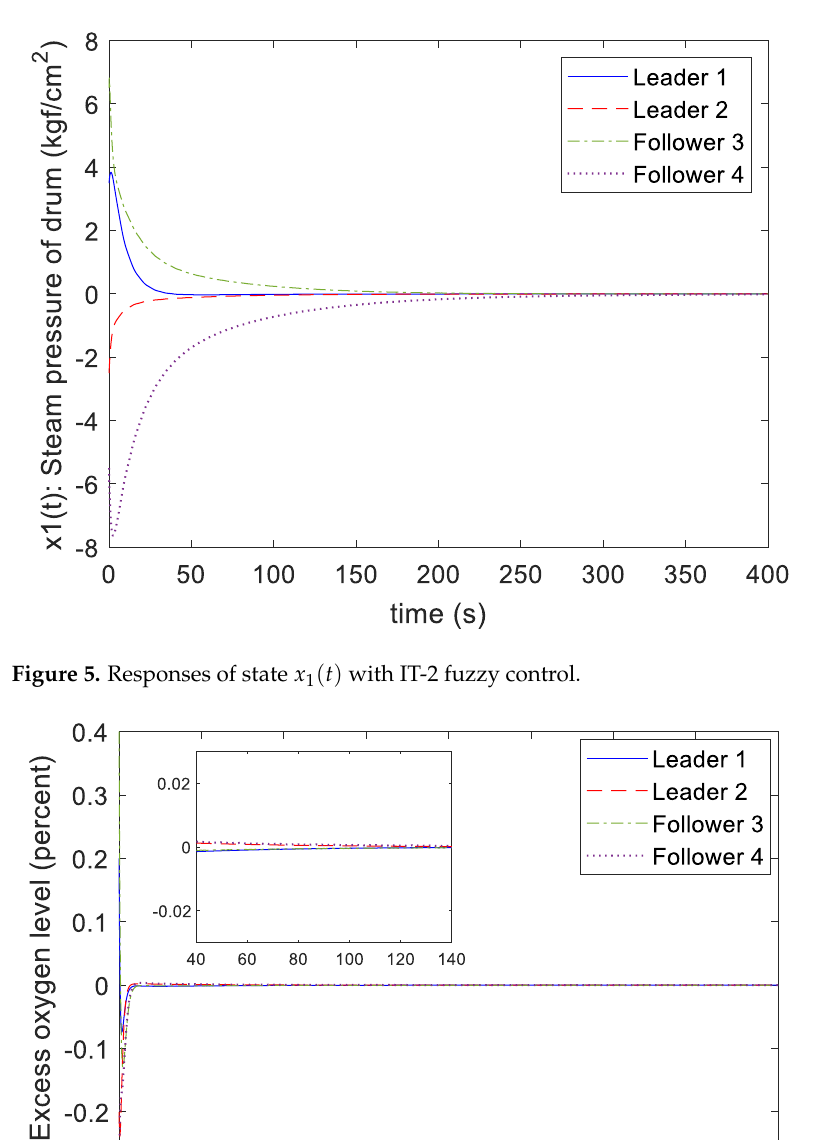
Figure 6. Responses of state x ( t ) with IT-2 fuzzy control.